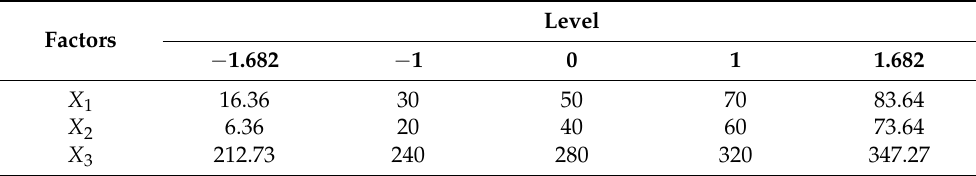
Table 1. Coded and actual levels of independent variables used in central composite design for ultrasound-assisted